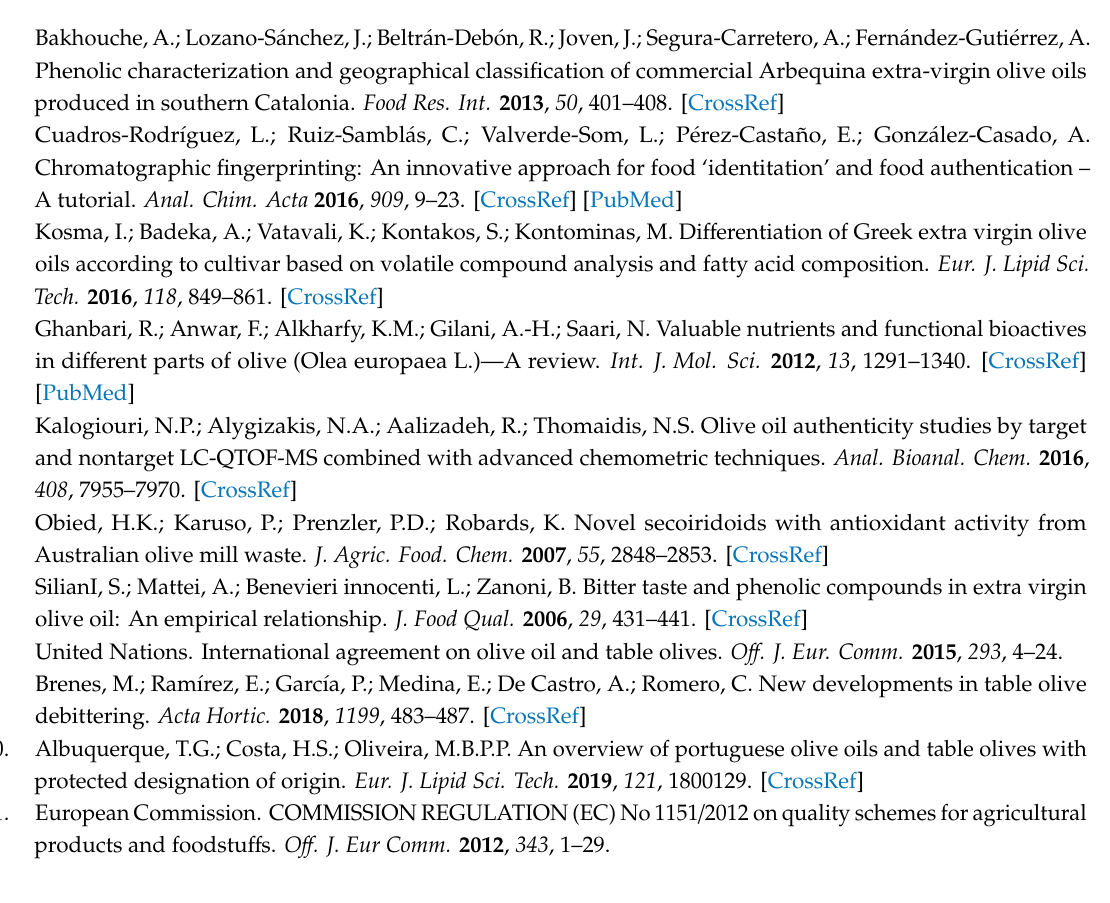
Supplementary Materials: The following are available online: Table S1: Target list of phenolic compounds, Table S2: Evaluation of scaling methods used by PLS-DA model, Figure S1: (a) EIC Chromatograms of the two mass features ( ± 5 mDa); (b) Centroid mode spectra for the tR of 3.53 min; (c) MS / MS spectra of hydroxytyrosol ( m / z 153.0558) eluting as same retention time as m / z